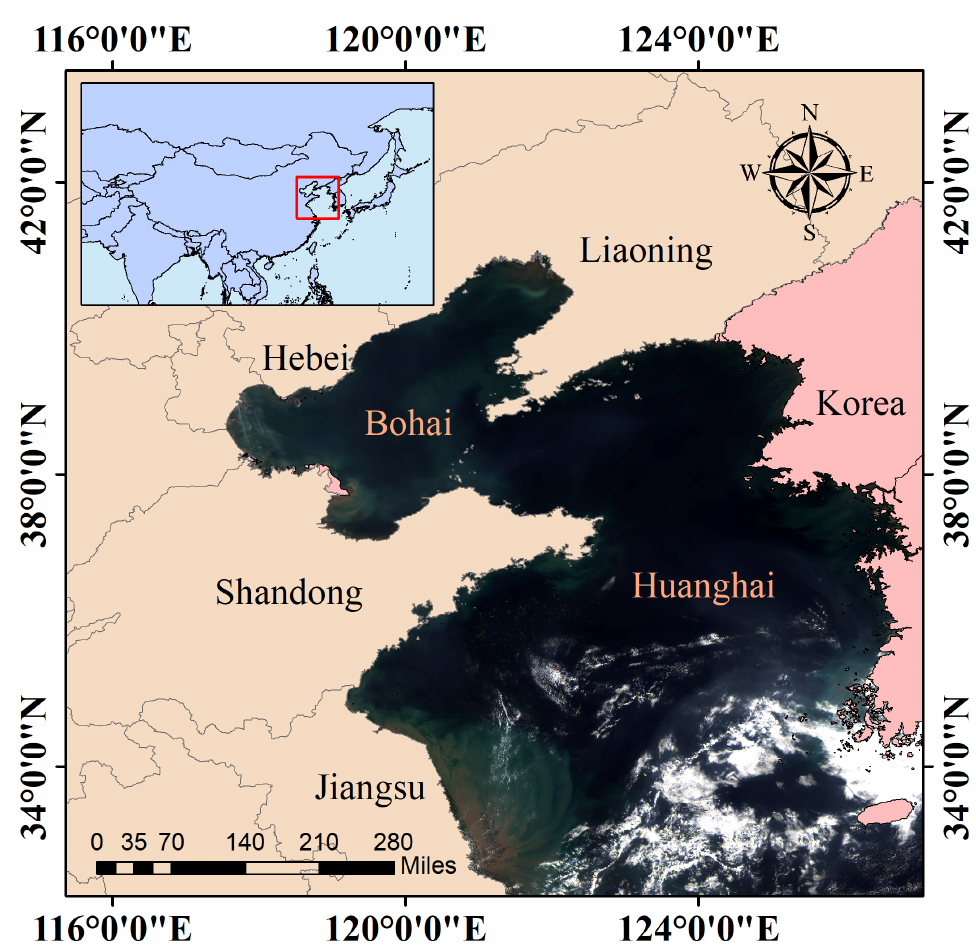
Figure 1. Location of the study area in the Yellow Sea and Bohai Sea.